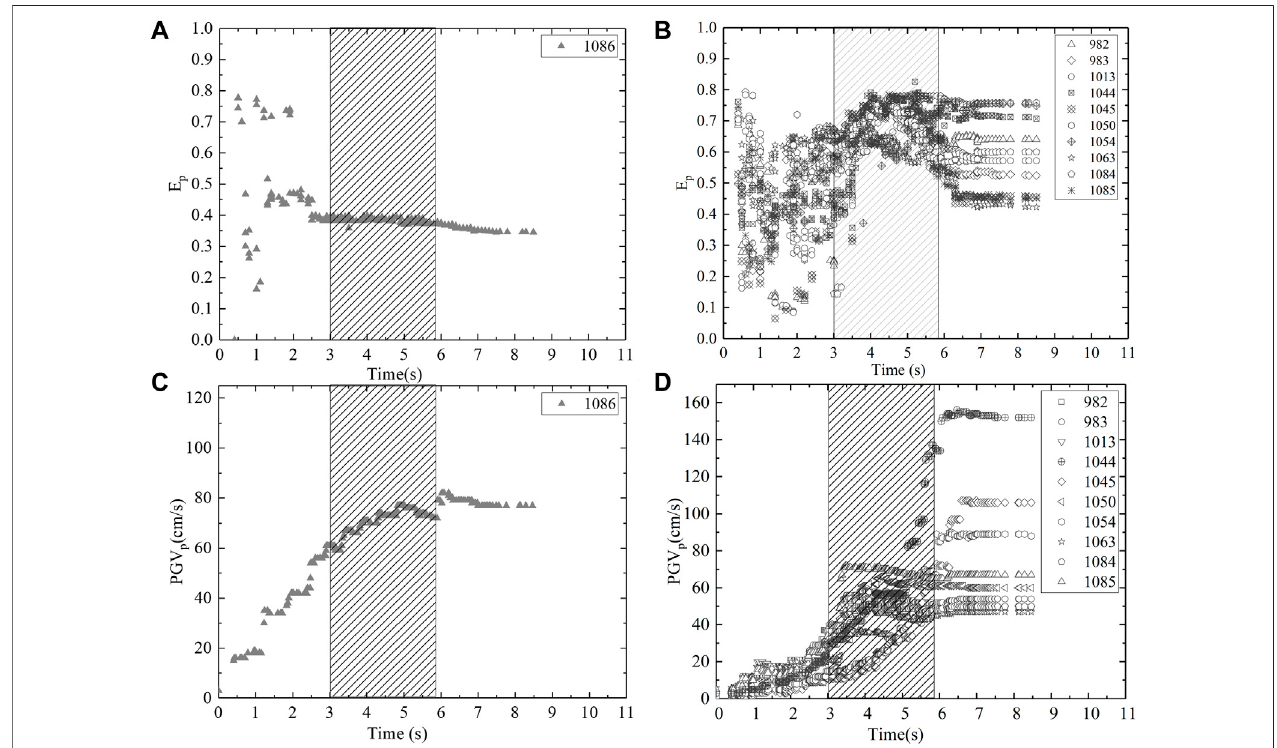
FIGURE6| E p valuesof fi nalgroundmotionsat (A) near-epicenterstationsand (B) rupture-directionstations, and PGV p valuesof fi nalgroundmotionsat (C) near- epicenter stations and (D) rupture-direction stations during the Northridge Earthquake.